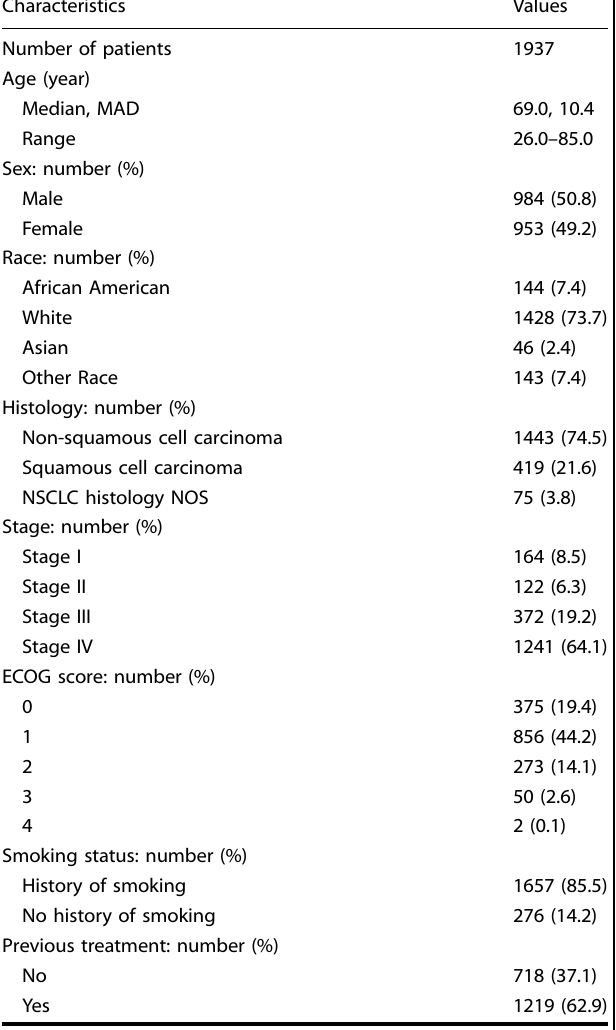
Table 1. Baseline demographic and pathologic